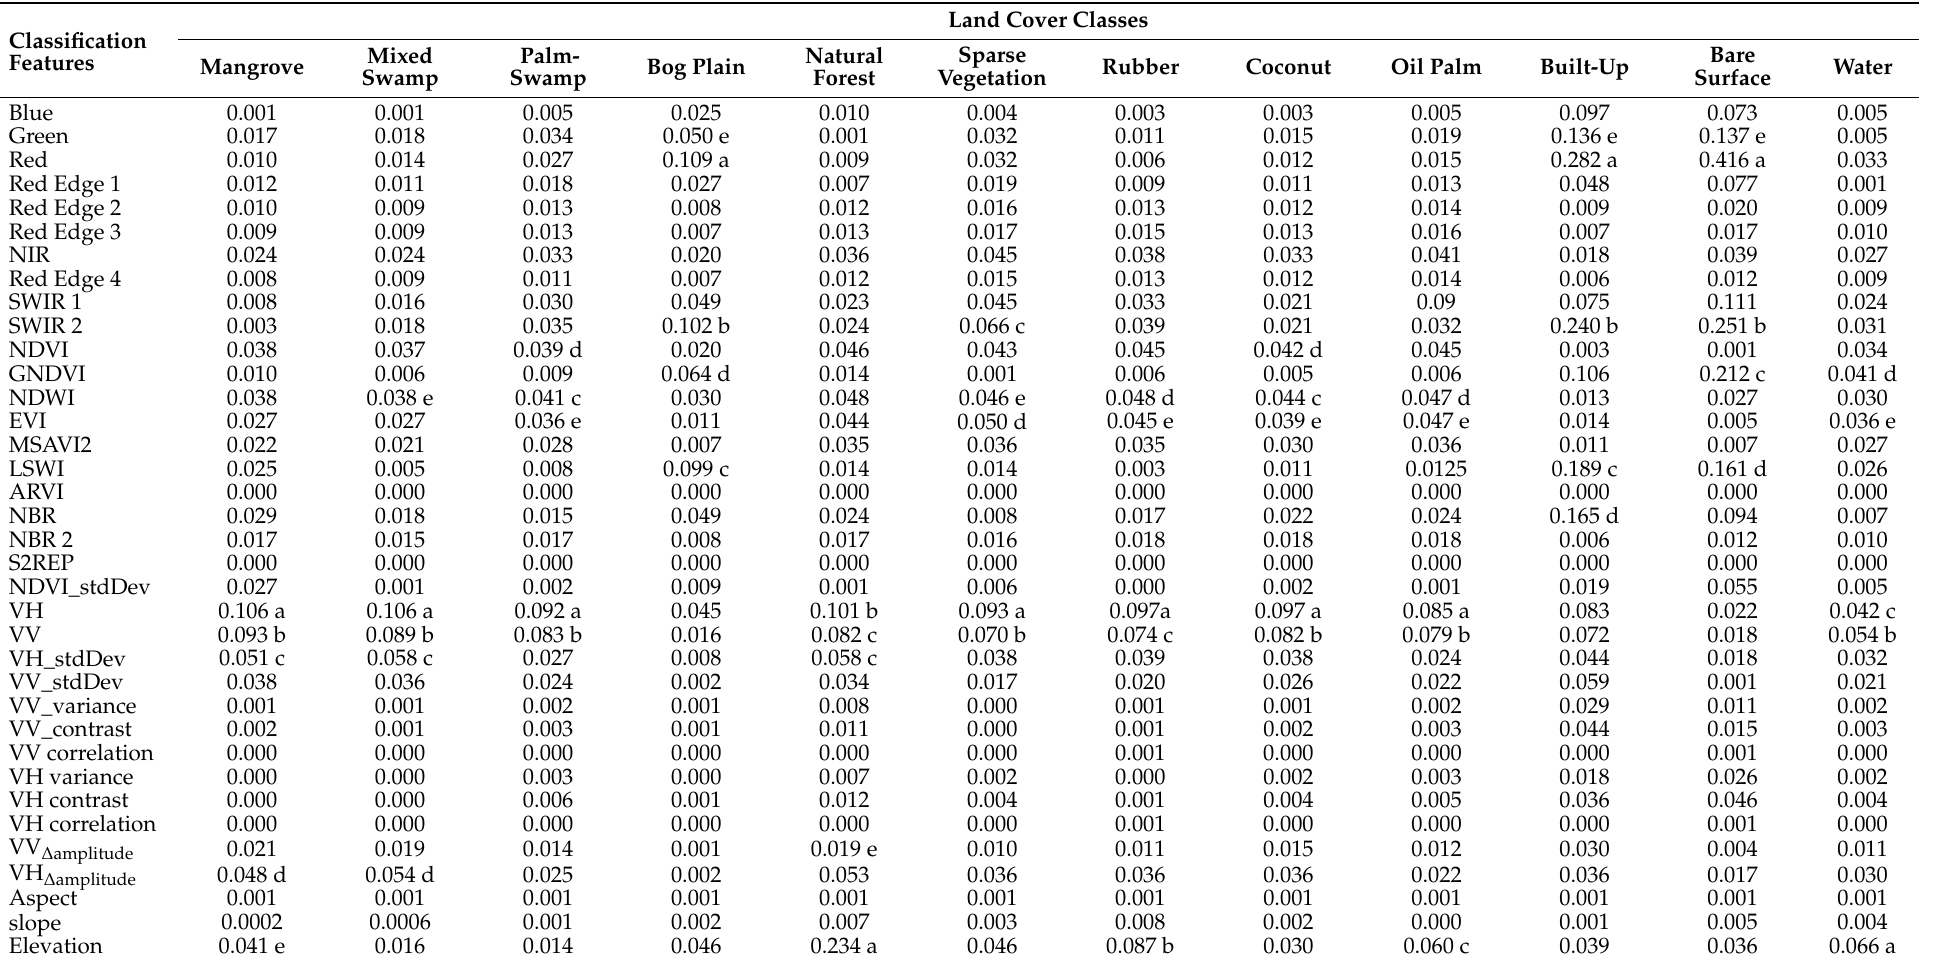
Table 7. S2+S1+DEM feature importance for discriminating various land cover types (a, b, c, d and e in shaded cells represent the five most important features, respectively). Classification